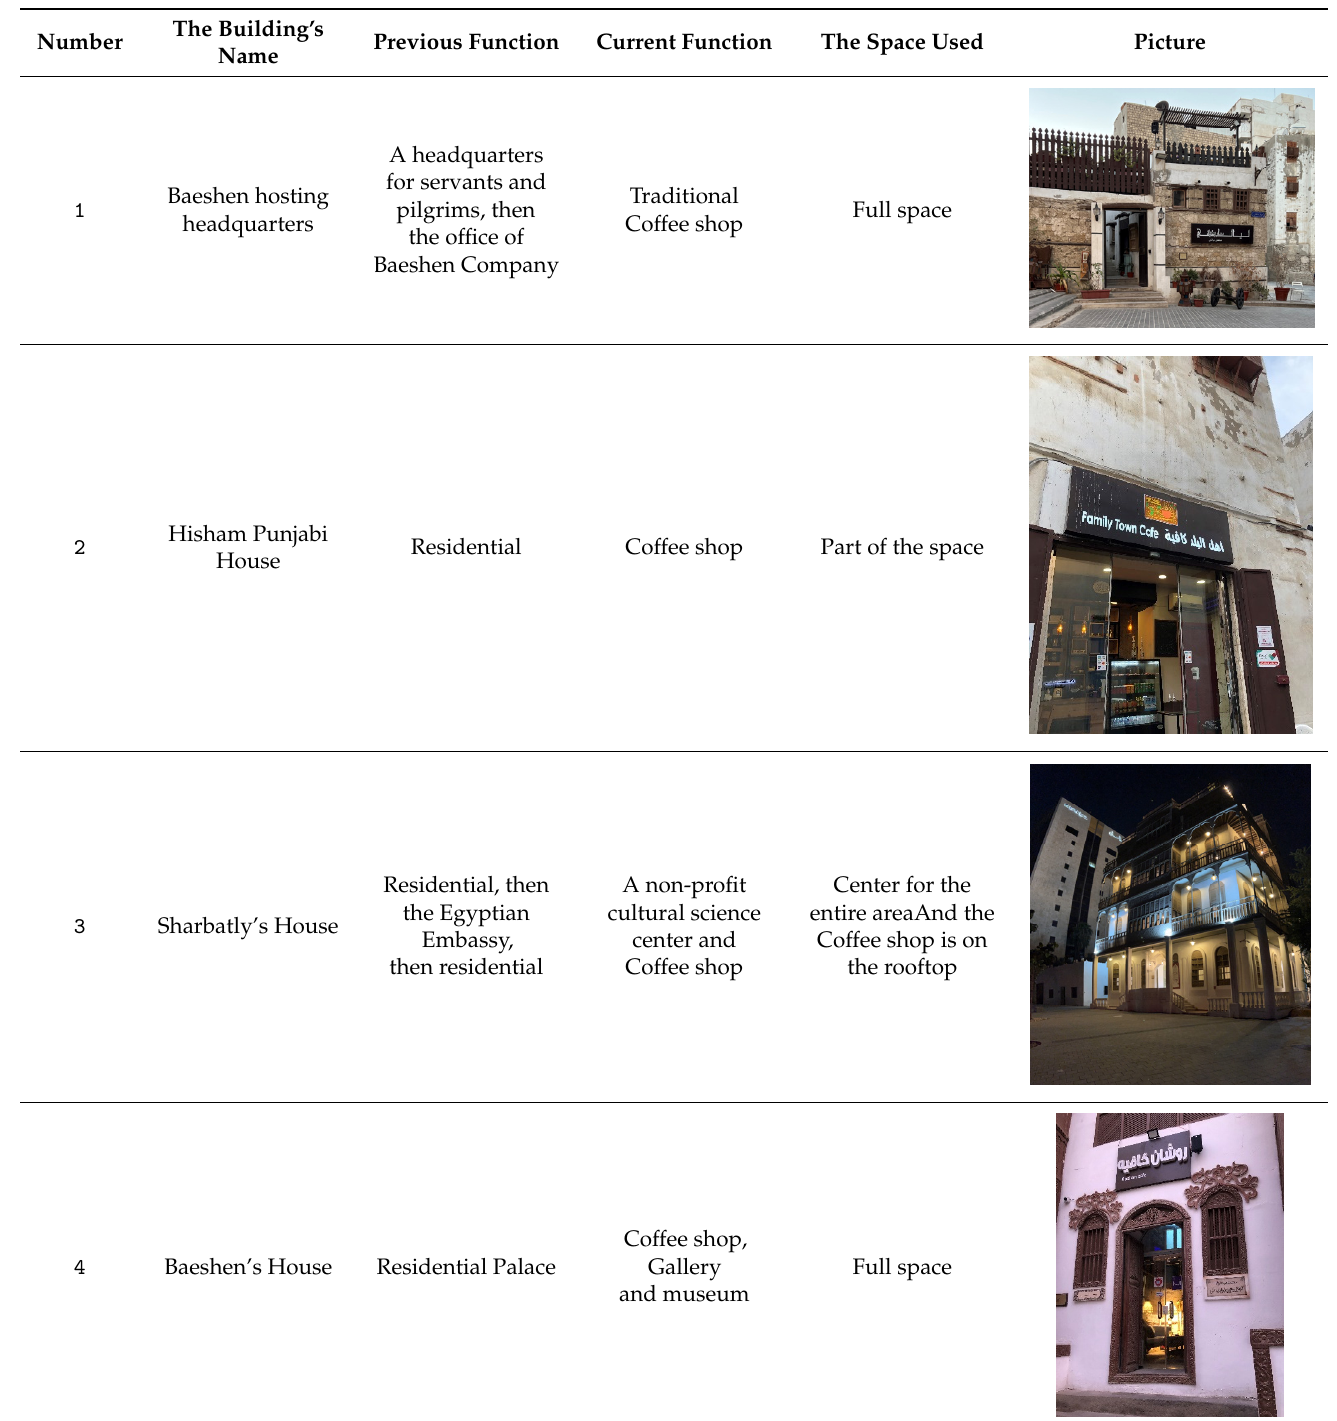
Table 1. Examples of some reuse projects in Jeddah.